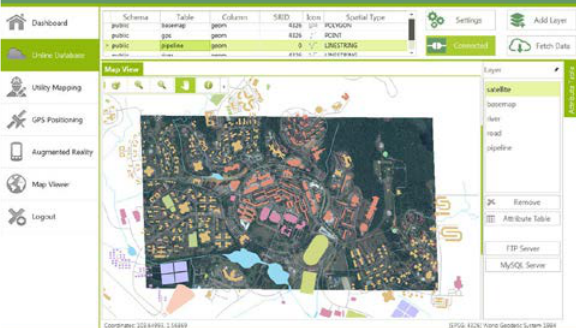
Figure 5. The mobile mapping application main interface shows raster layer (satellite) being mapped collaboratively with others layers using data from database.gpkg.